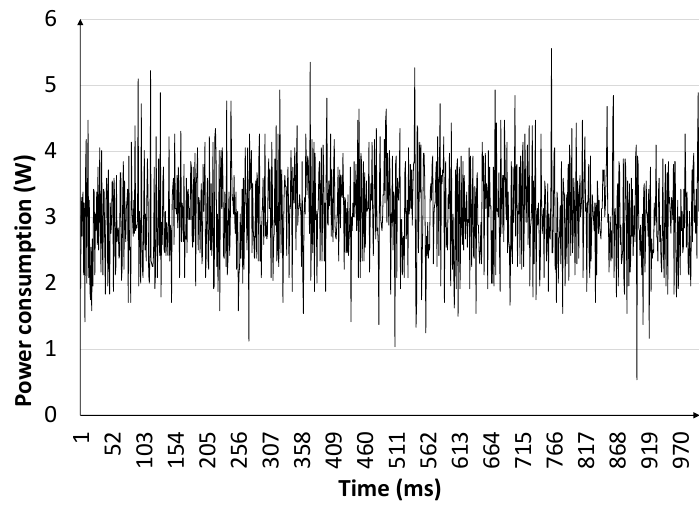
Figure 1. Sample measurement of stepper motor power